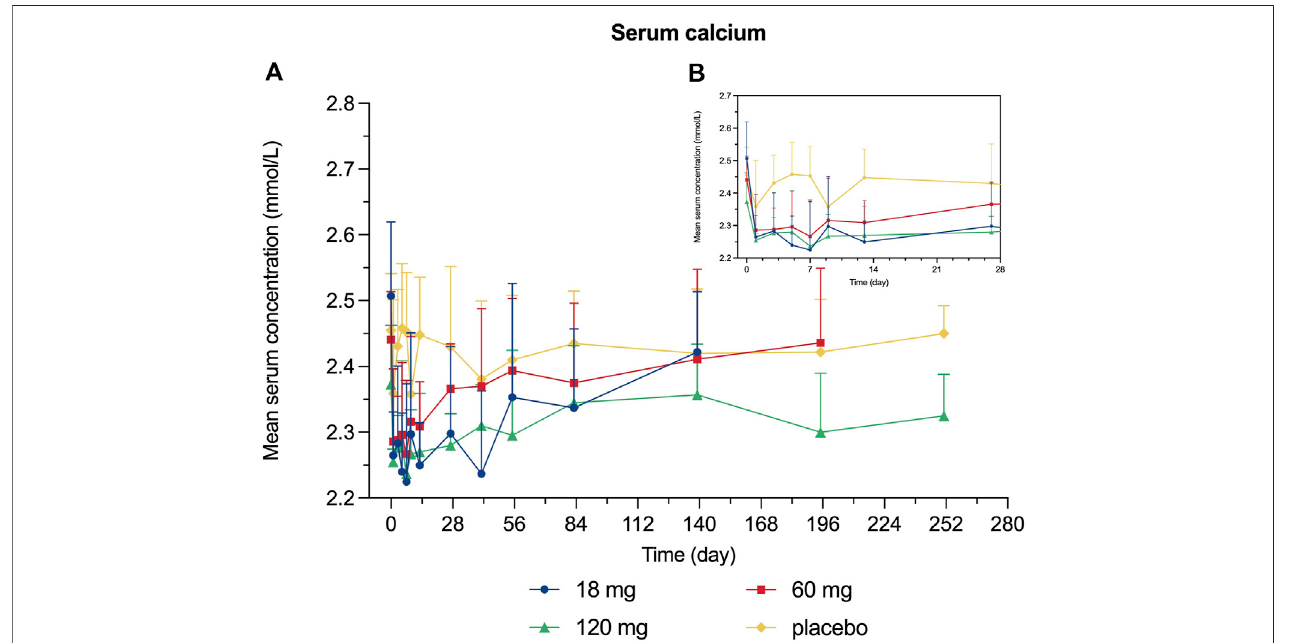
FIGURE 4 | Percent change from baseline in serum calcium. (A) day 0~day 252; (B) day 0~day 28.